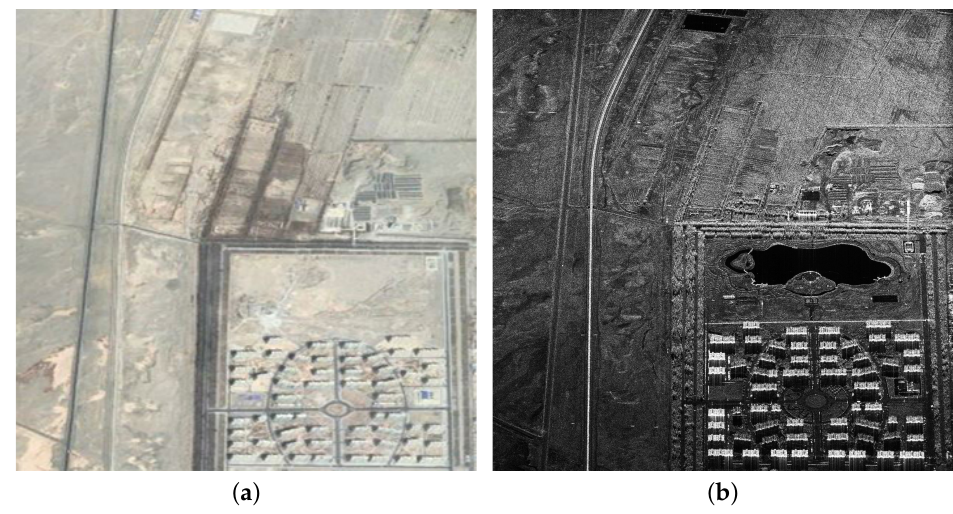
Figure 2. ( a ) Google map and ( b ) SAR amplitude image of the study area.